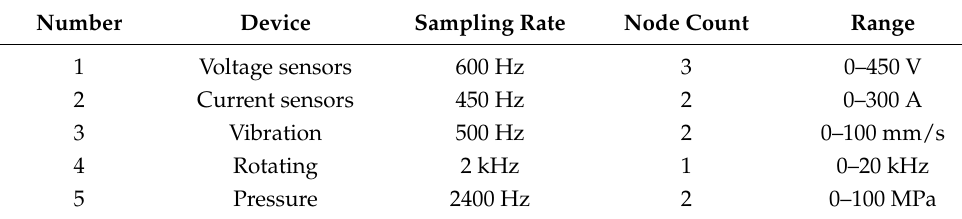
Table 1. Specification of different sensors installed on the production line.